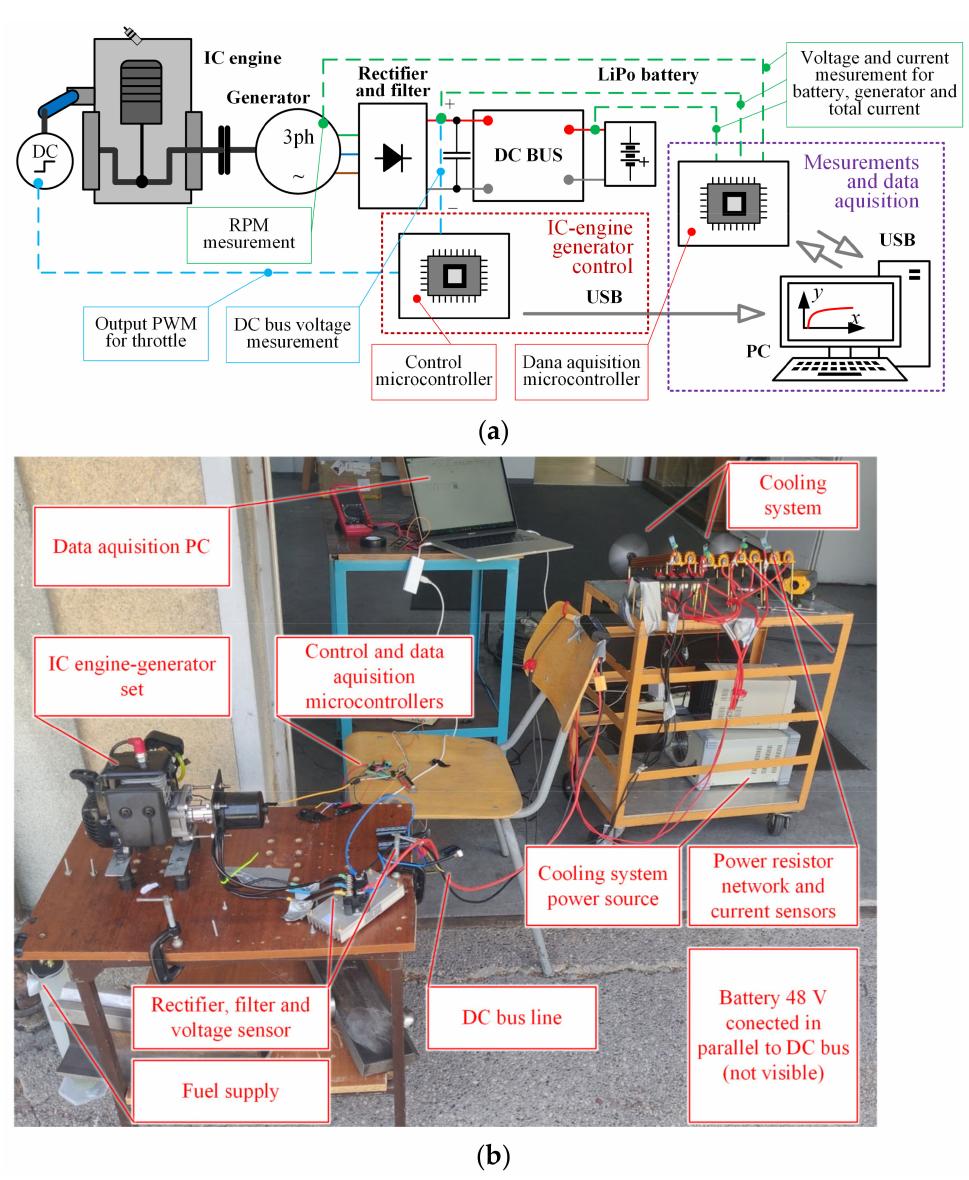
Figure 14. Experimental setup: ( a ) Schematic view; ( b ) Photograph of experimental